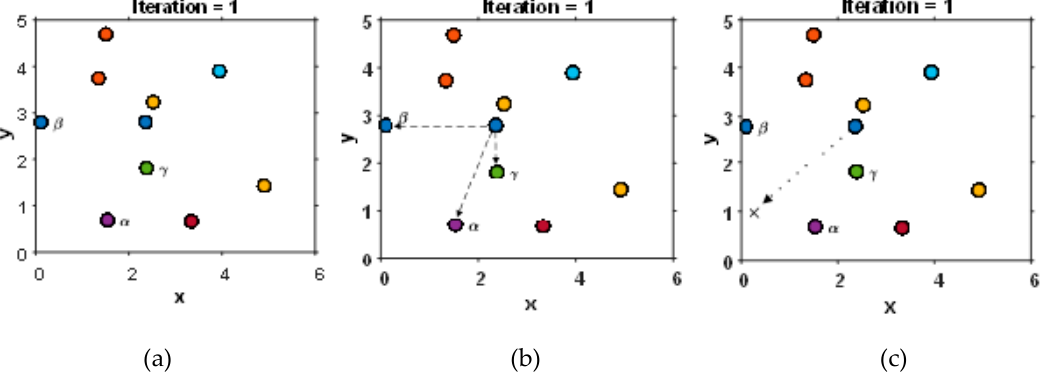
Figure 2. GWO simulation at first iteration: (a) initialization of grey wolf population and searching for the non-dominated agents by the cost sphere function of Equation (1); (b) calculating the divergence of each agent positions to 𝛼, 𝛽,𝛾 agents in Equation (2); and (c) calculating the next agent position by Equations (3) and (4). The position of agent 𝑥(𝑡) = 2.3531,𝑦(𝑡) = 2.8036 will change the position in the next iteration to 𝑥(𝑡 + 1) = 0.2914,𝑦(𝑡) = 0.9727, where 𝑡 = 1 .